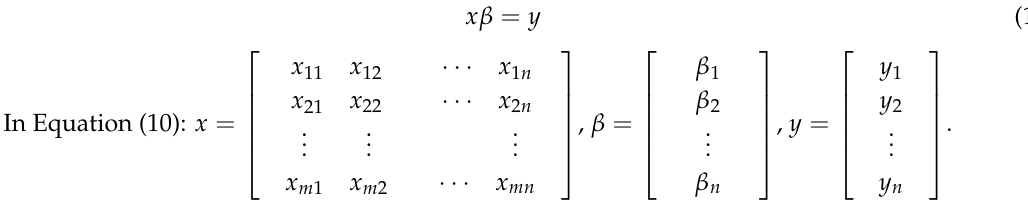
Figure 3. Cumulative probability distribution curves of vibration signal in different working states of the